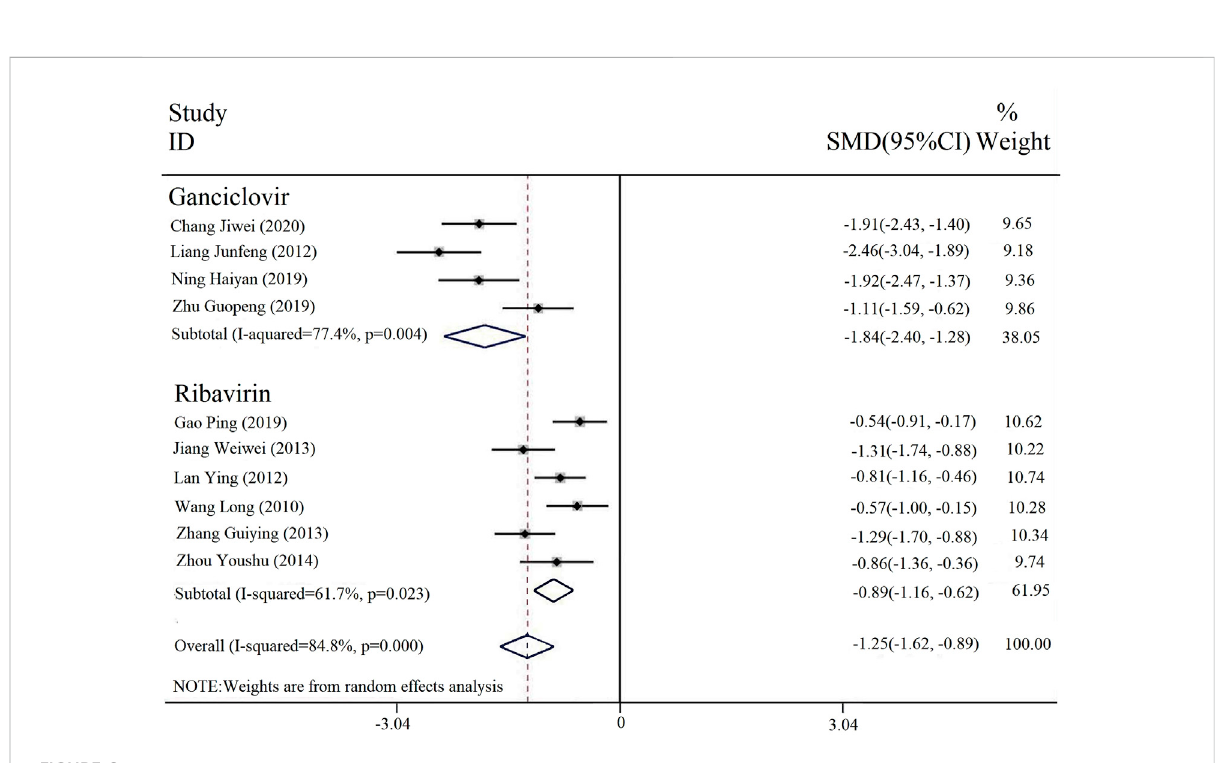
FIGURE 6 Forest plot of duration of the parotid gland